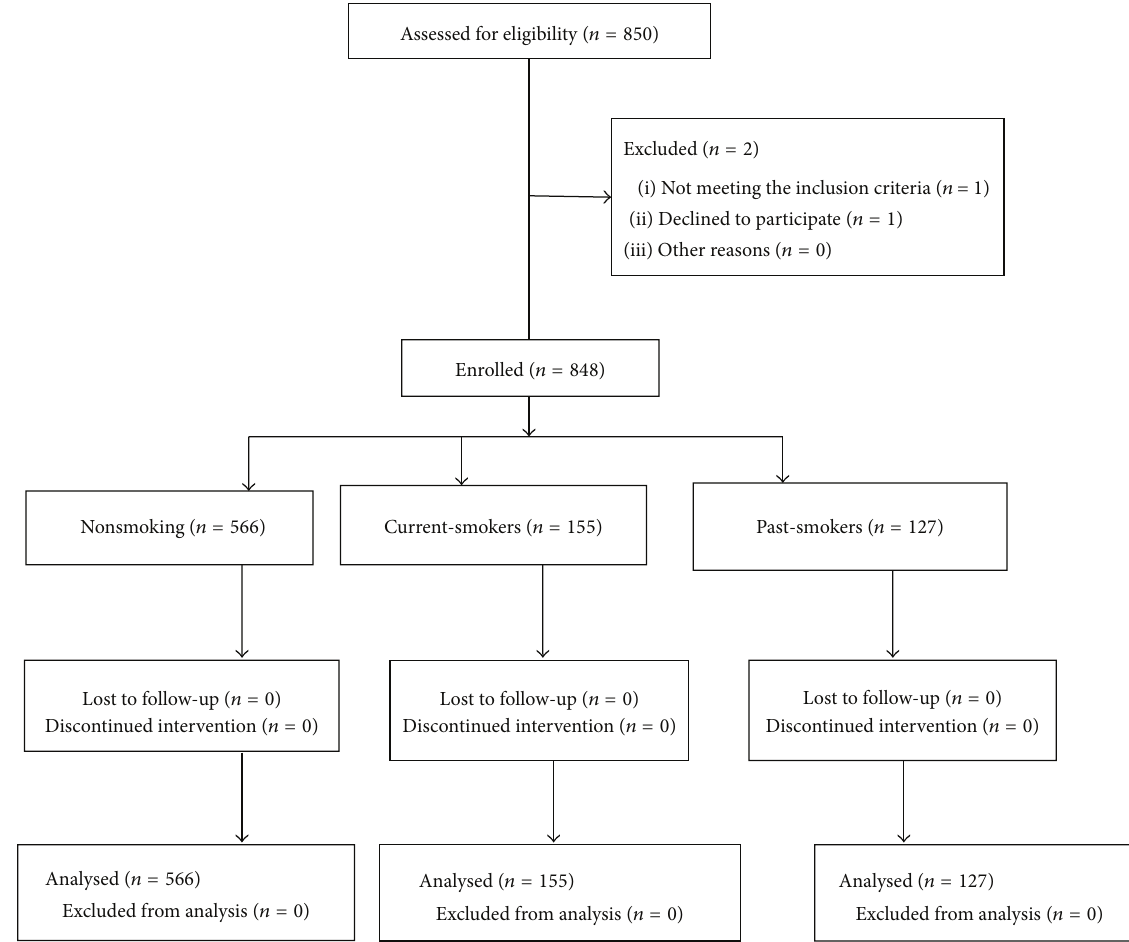
Figure 1: Patient eligibility and selection.